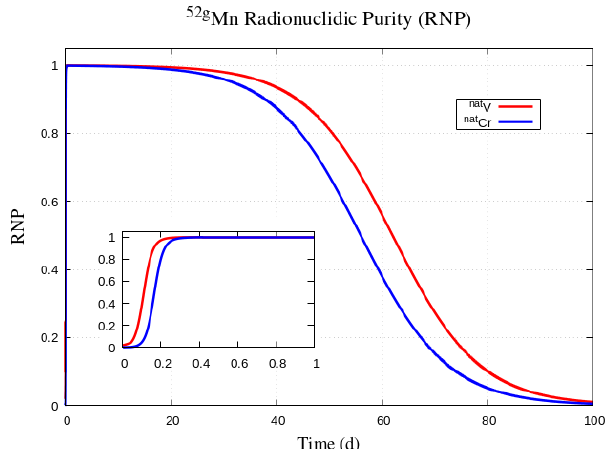
Fig. 4. Comparison between the Radionuclidic Purities of 52g Mn for the two reactions with Nat V and Nat Cr, for 1 μ A beam current, 1 h irradiation time and 200 μ m target thickness. The inset shows the evolution for the first 24 h, including the irradiation